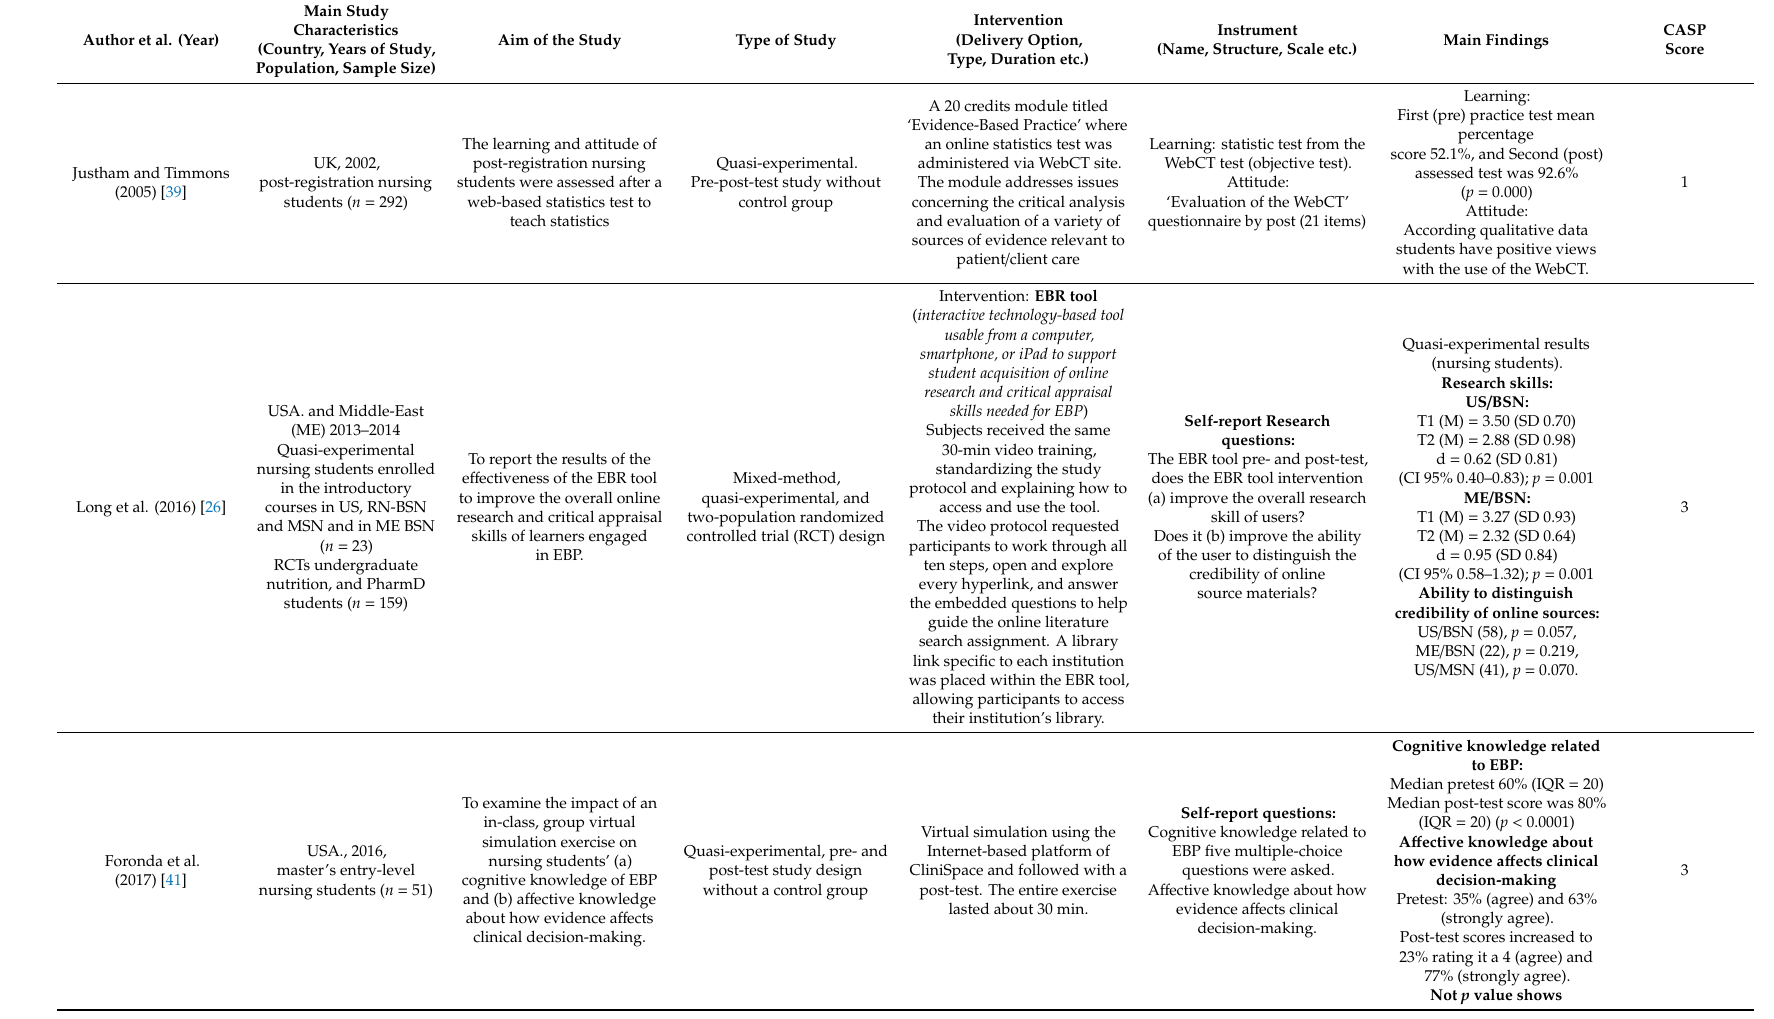
Table 3. Data extraction for on-line / by distance used method to teach